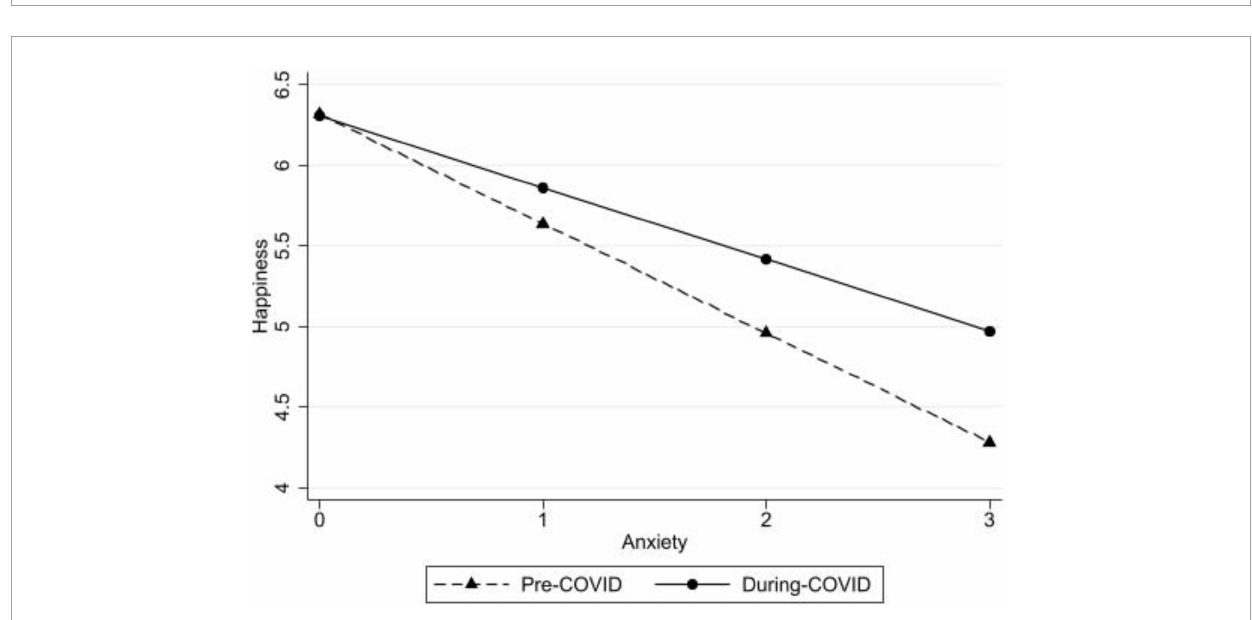
FIGURE2 Anxiety symptoms predicting happiness pre- and post- the COVID-19 pandemic declaration with the full sample.